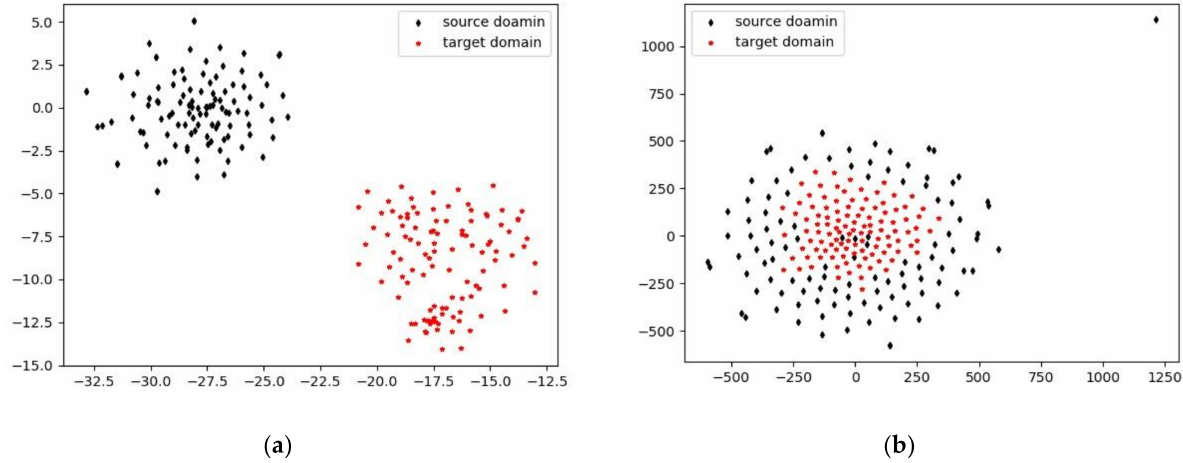
Figure 6. Two-dimensional t-SNE visualizations from the features of the Toronto and miniSAR samples. Black: 110 samples from Toronto dataset; Red: 110 samples from miniSAR dataset. ( a ) Feature visualization of Toronto and miniSAR samples without adaptation; ( b ) Feature visualization of Toronto and miniSAR samples via our proposed